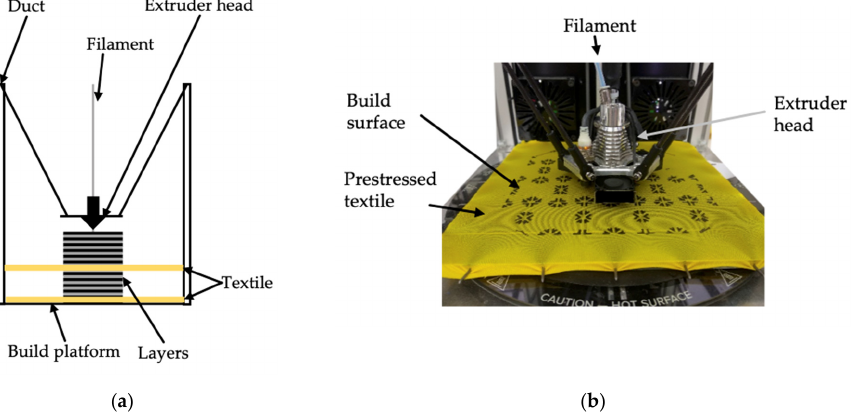
Figure 3. 3D printing on textile production process: ( a ) adding layers of textile in the 3D printing process; ( b ) 3D printed layers of plastics on textiles with 3D printing.